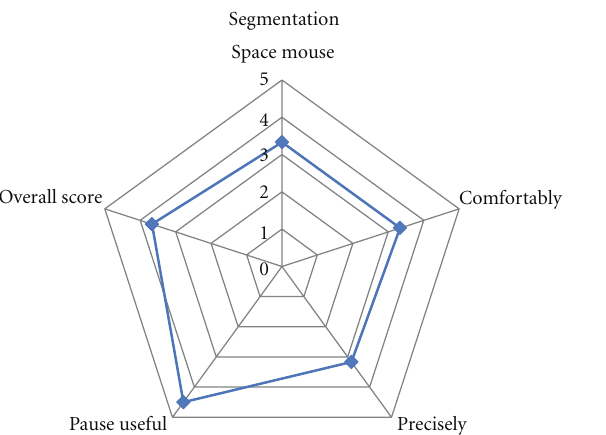
Figure 8: Force feedback questionnaire scores from the subjective